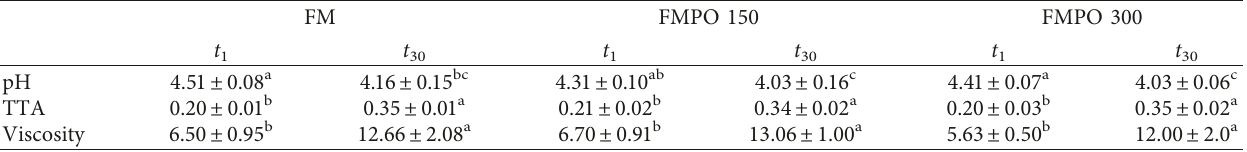
Table 2: pH, TTA, and viscosity of FMPO 150, FMPO 300, and FM during